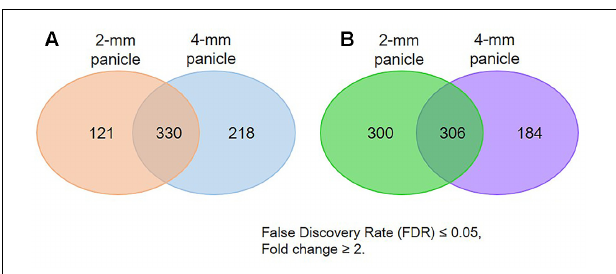
FIGURE 5 | Number of genes differentially expressed in osvil2 young panicles. (A) Number up-regulated; (B) number